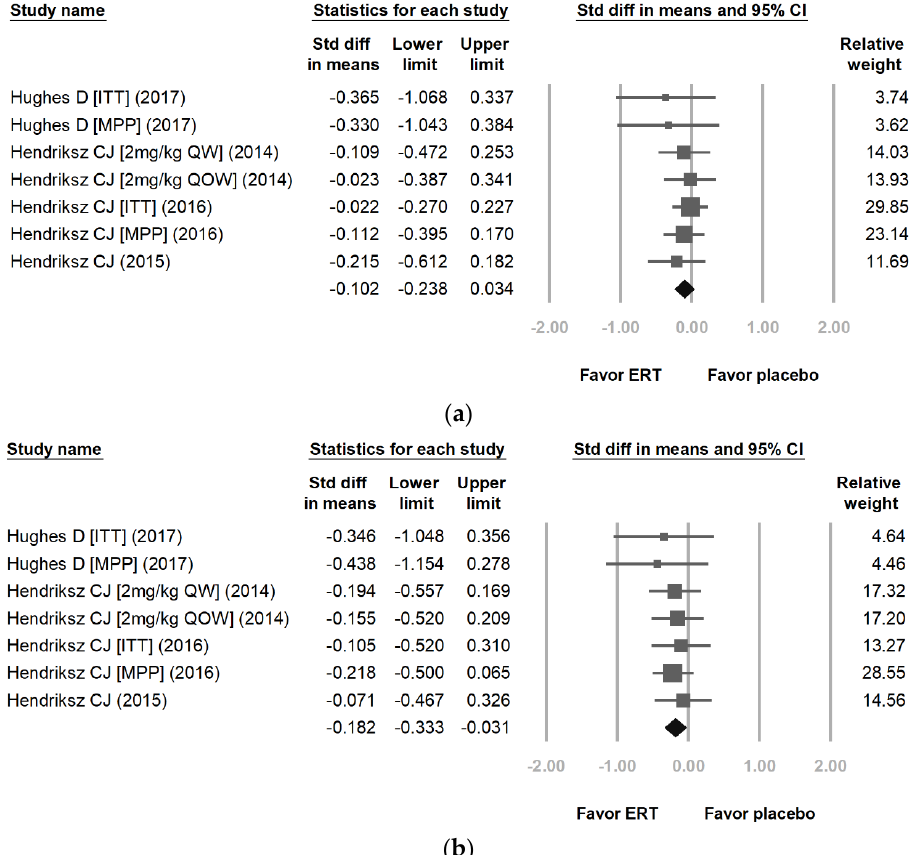
Figure 3. Proportional meta-analysis result for a pooled proportion from two cohort studies and two randomized controlled trials (RCTs) for the ( a ) 6-min walk test (6MWT) and ( b ) 3-min stair climb test (3MSCT) in MPS IVA. The pooled proportions analysis showed that the difference in means of 6MWT and 3MSCT between the enzyme replacement therapy (ERT) group and the placebo treatment group were ( a ) − 0.102 [95% CI: − 0.238, 0.034; heterogeneity: I 2 = 0.00%, p = 0.935; overall effect: p = 0.042] and ( b ) − 0.182 [95% CI: − 0.333, − 0.031; heterogeneity: I 2 = 0.00%, p = 0.976;